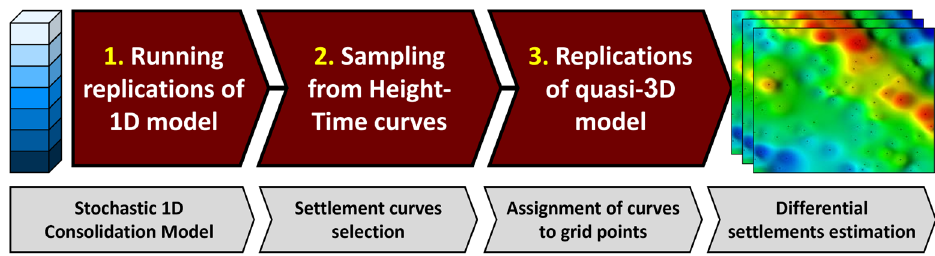
Figure 1. The methodology of quasi-3D consolidation modeling.